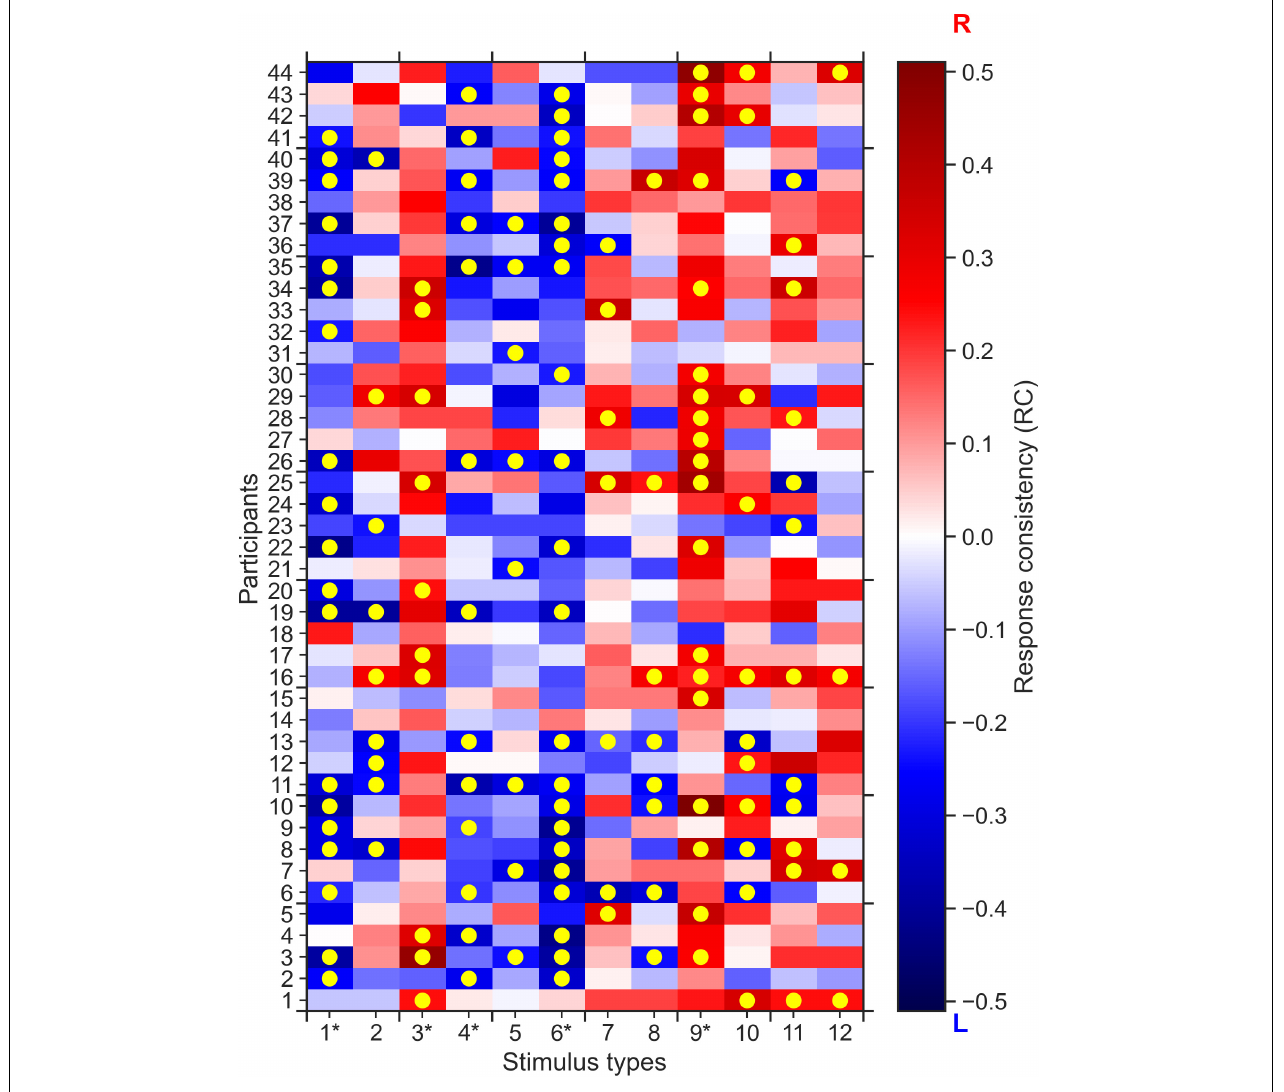
FIGURE 2 | 0% coherence trials: Response consistency (RC) map across 44 participants and 12 stimulus types. Positive RC values (red) report the tendency of a participant to choose the rightward direction, whereas the negative RC values (blue) report the tendency for the left direction. Yellow circles indicate significantly ( p < 0.05, corrected for number (12) of stimulus types) consistent right (dark-red) and left (dark-blue) responses of a specific participant, across up to 20 repetitions of a specific stimulus type. One can clearly see that for stimulus types 1, 3, 4, 6, and 9 (indicated by an asterisk), most participants have mostly the same consistent responses, e.g., we see mostly red colors for stimulus type 9, i.e., the participants tend to respond right more than they do